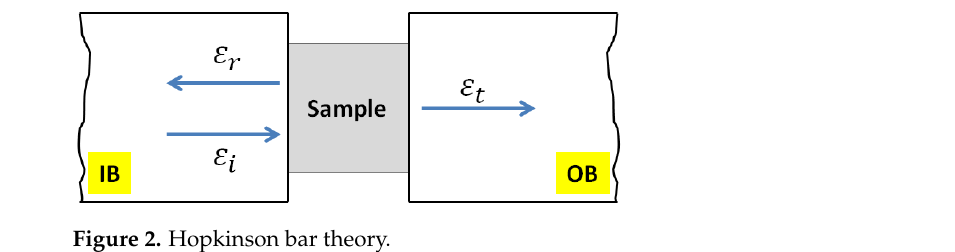
Figure 2. Hopkinson bar theory.